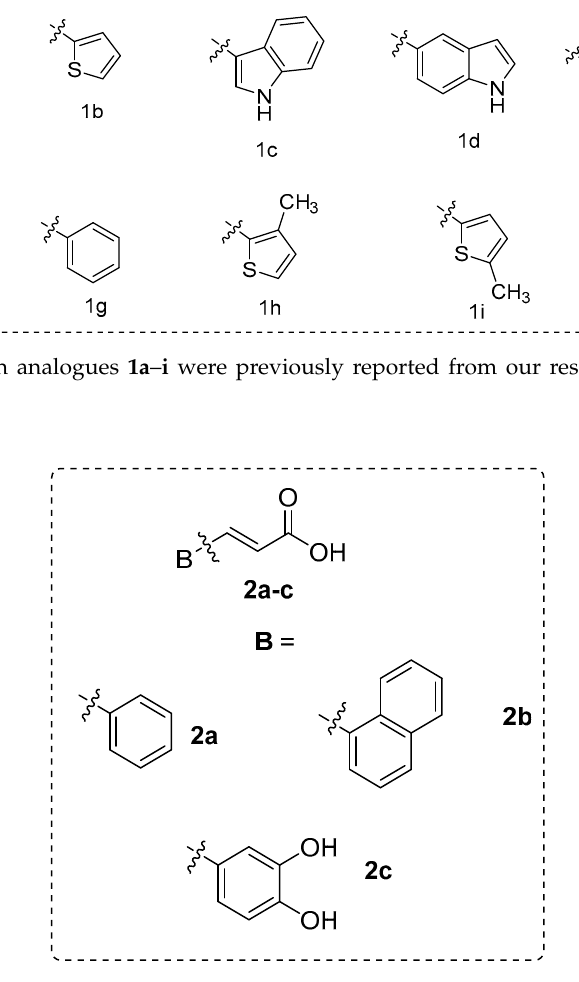
Figure 4. The selected cinnamic acids.